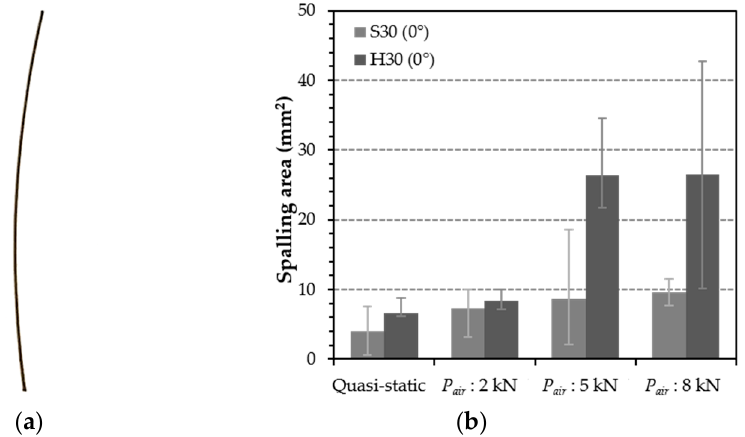
Figure 17. ( a ) Picture of a slightly curved S-fiber and ( b ) spalling areas of S- and H-fibers with various loading rates.